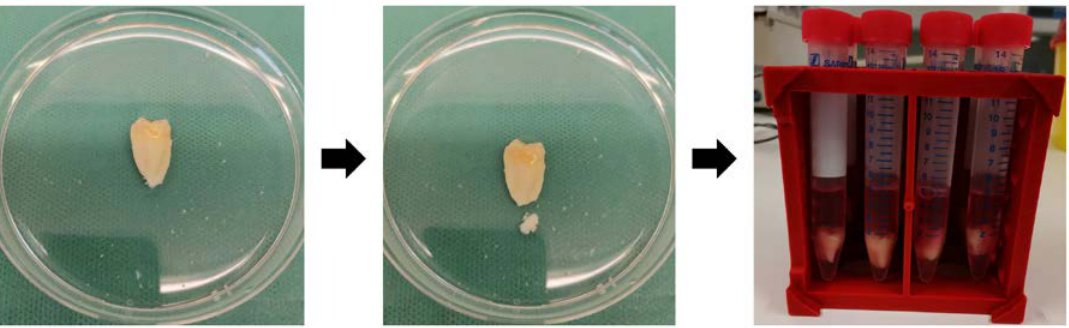
Figure 9. The procedure of teeth treatment in T1 and T2 frozen groups: 1/3 of the apical was removed and stored in the freezing medium containing DMSO.